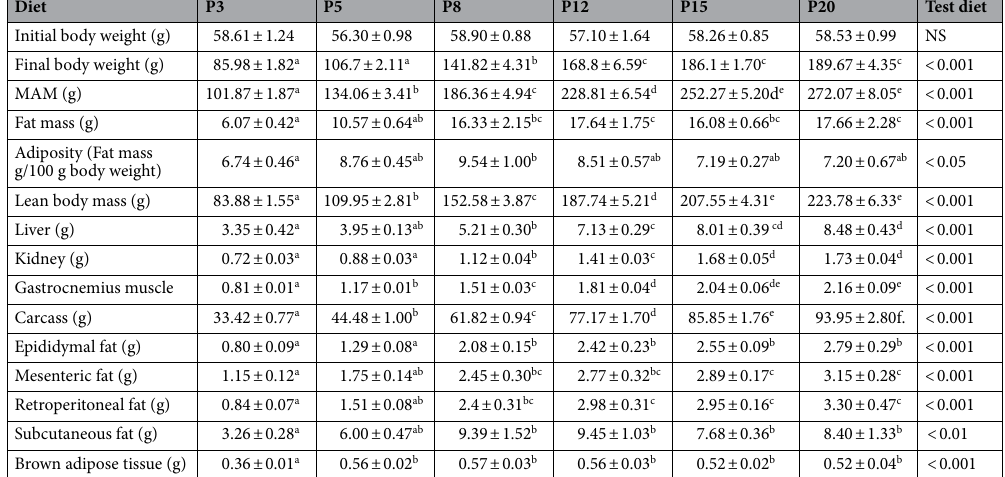
Table 2. Absolute and relative values of body composition. Values are means ± SEM (n = 6 per group). a,b,c,d Data that do not share the same letter are different at the P < 0.05